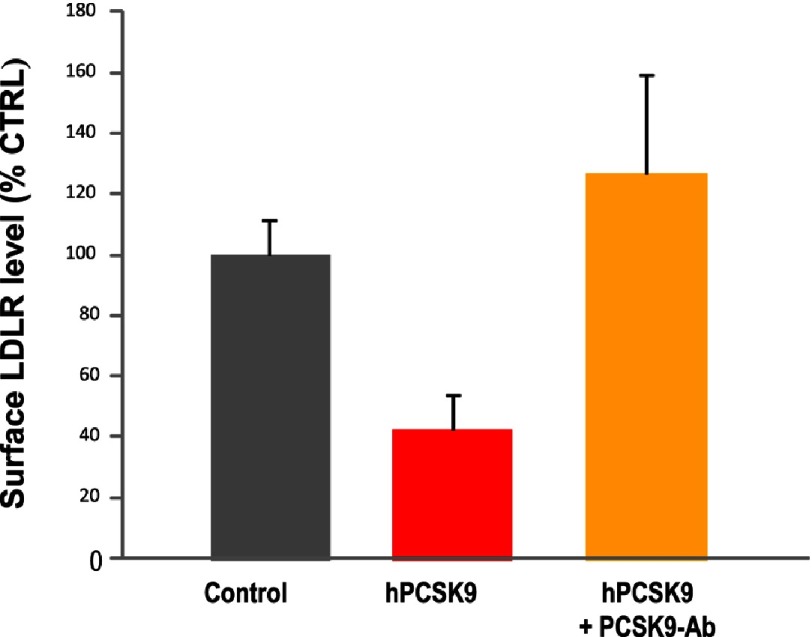
Effect of affinity purified PCSK9 polyclonal antibody on LDLR levels in HepG2 cells.Human PCSK9 (0.6 µg) was pre-incubated at neutral pH and 37°C for 1 h with saline control or 5 µg of a previously reported affinity-purified polyclonal antibody to PCSK9.55 These solutions were then incubated with HepG2 cells for 6 h, following which the cells were suspended and immediately analyzed by FACS for surface human LDLR levels.58 Notice that PCSK9 reduces the cell surface LDLR by >60%, and that the PCSK9 antibody completely reverses this activity on the LDLR.